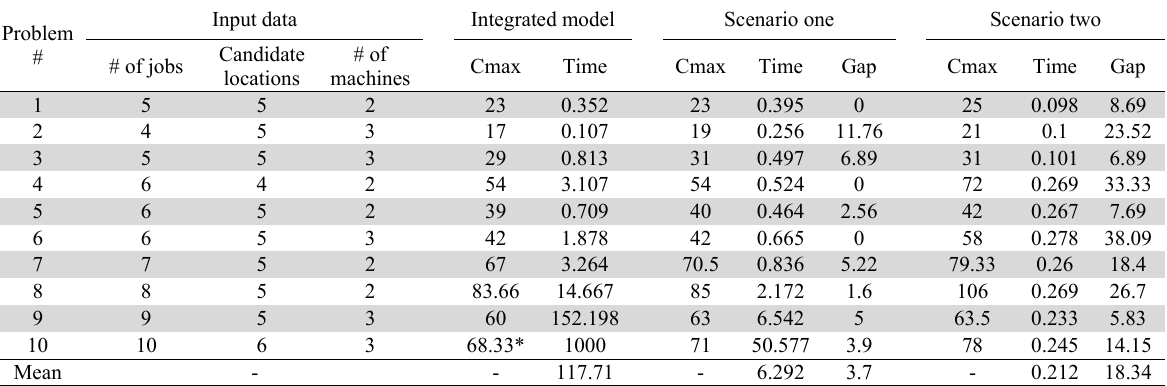
The results of the optimal solution for 10 sample test problems Problem